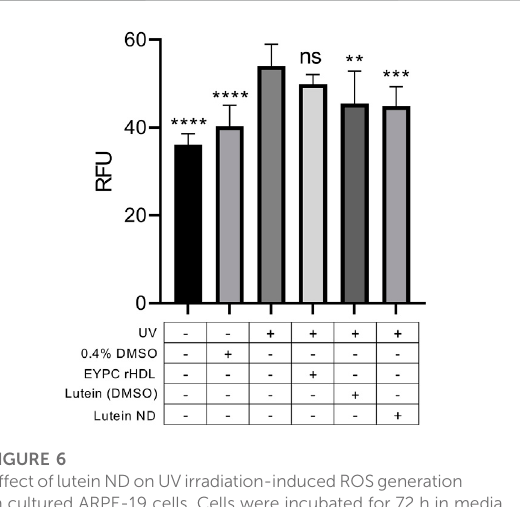
FIGURE 5 Effect of UV irradiation on ARPE-19 cell viability. Cells were incubated for 72 h in media only, media + 0.4% DMSO, media + EYPCrHDL,media+lutein(8.8 μ M)inDMSO,ormedia+luteinND (8.8 μ M as lutein). Following incubation, cells in indicated treatment groups were exposed to UV irradiation for 2 h. Following irradiation, cell viability was assayed and sample fl uorescence emission monitored at 590 nm (excitation 530 nm). Values reported are the mean ± standard error ( n = 10); **** = p < 0.0001 vs. control, ns = not signi fi cant.